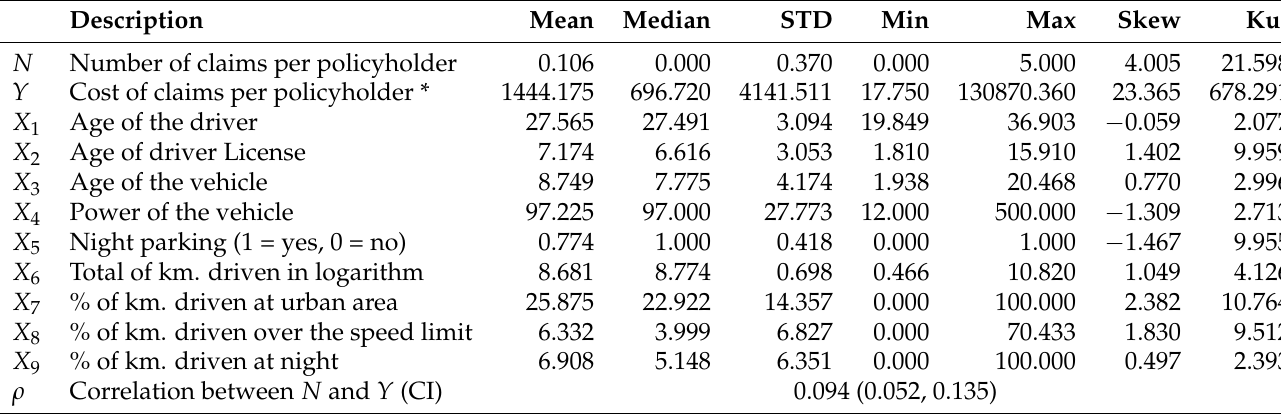
Table 1. Definition of variables and descriptive statistics: mean, median, standard deviation (STD), minimum (Min), maximum (Max), skewness (Skew) and kurtosis (Kur). The last row shows the linear correlation between the dependent variables and a confidence interval (CI) at a 95% level.